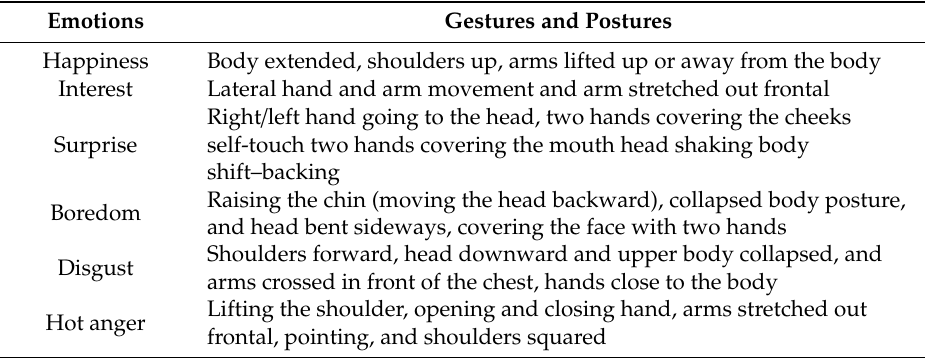
Table 12. Relations between emotions and body posture